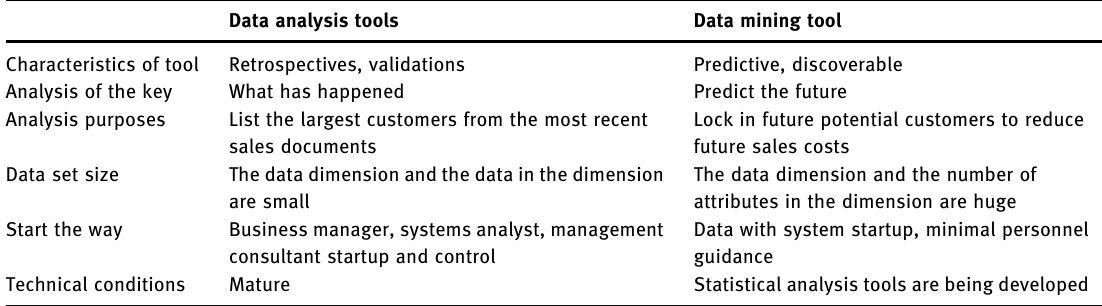
Table 1: Di ff erences between data mining tools and traditional analysis